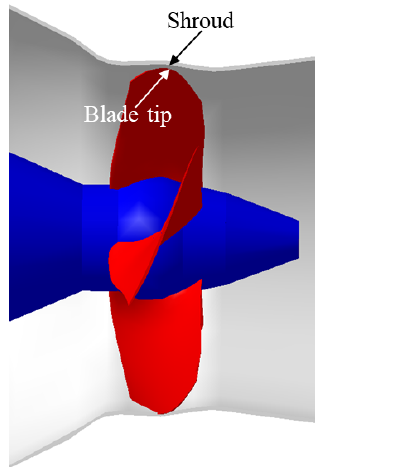
Figure 1. Clearance between blade tip and